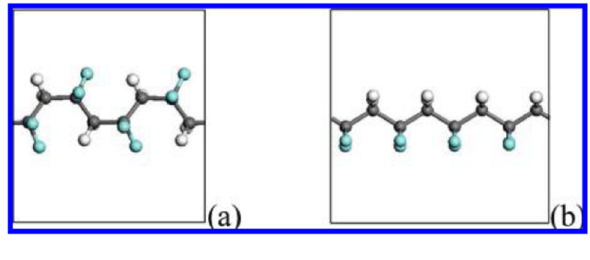
Figure 1: Molecular chains of ( a ) α - and ( b ) β - phase [ 17 ] .